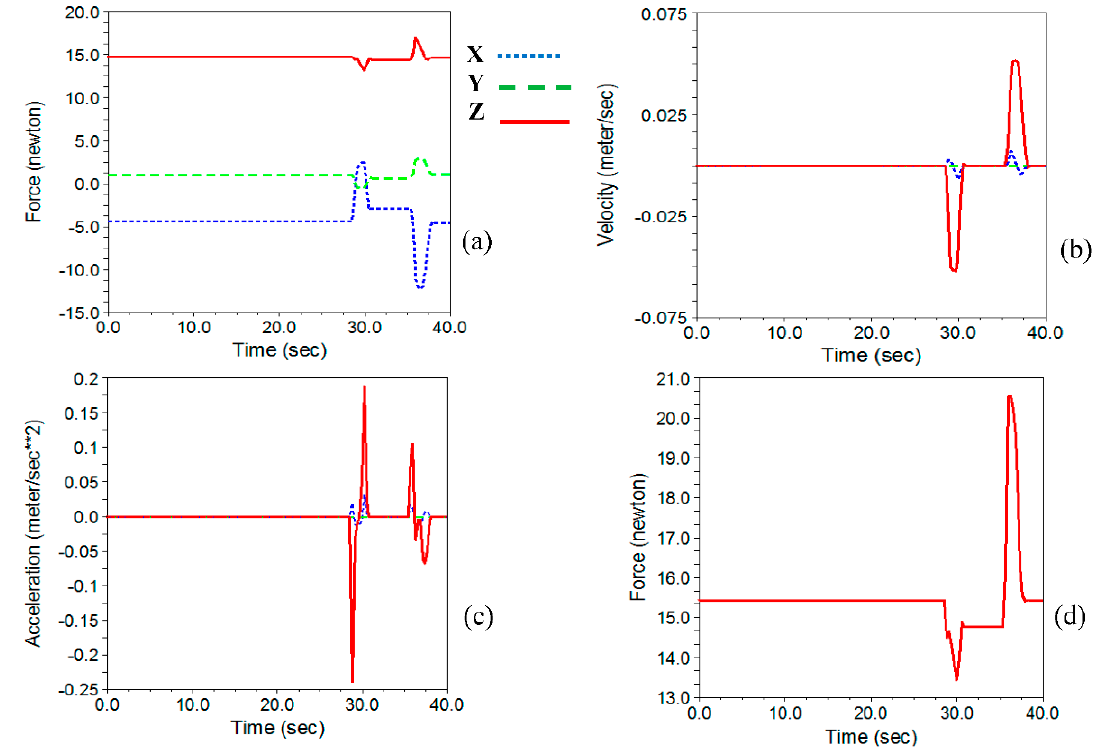
Figure 26. Results of ADAMS software simulation to determine the characteristics of the pneumatic jack of the cleaning subsystem (four fish per minute). In this figure, ( a – d ) are force, velocity, acceleration, and resultant of the force in three direction respectively.